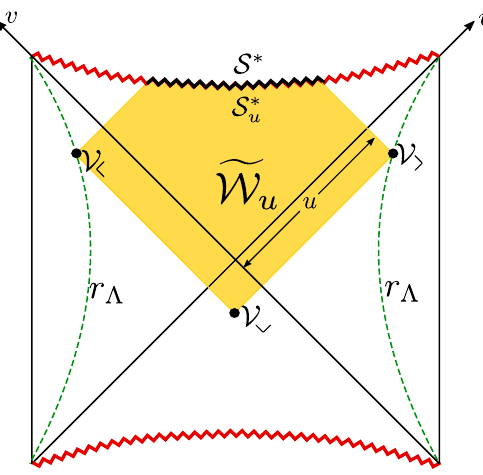
Figure 6 . Wheeler-deWitt patch g W u achored on the regularization surface r (cid:3) . The terminal complexity for the singularity slab S (cid:3) u along the